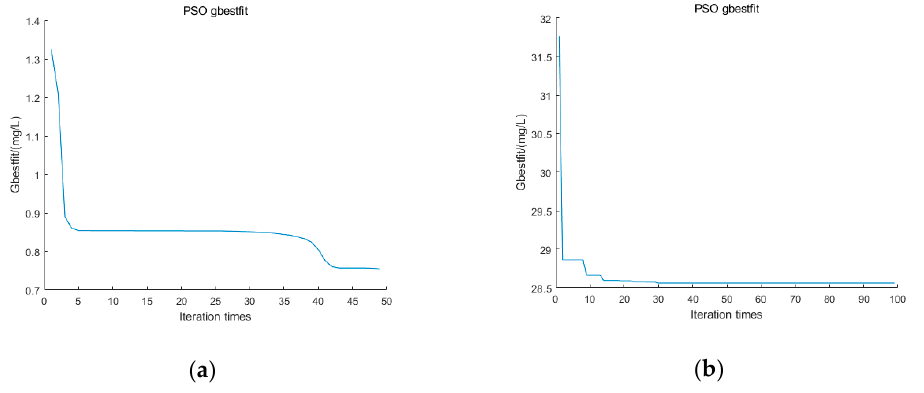
Figure 11. Fitness curve of PSO optimization: ( a ) BR; and ( b ) SP.